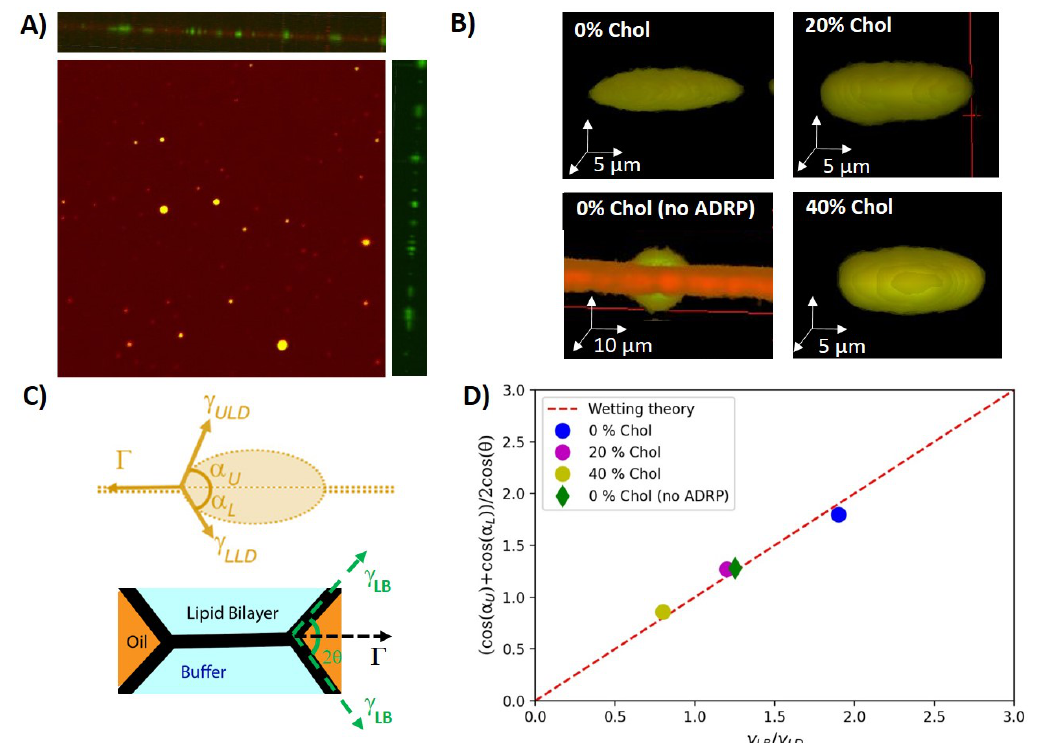
Figure 2. ( A ) Top view of a free-standing bilayer containing LDs. A side view of a 3D scan is provided in the top panel. The right panel provides the corresponding side view with only the protein channel. All the proteins are labeled in green (Alexa 488) and 2% (molar ratio) DOPE is labeled in red (Cy5). ( B ) 3D reconstructions of individual bilayer-embedded LDs for 0%, 20%, and 40% cholesterol, respectively (with 1 µ M ADRP). For comparison, the 3D reconstructions of a bilayer- embedded LD with 0% cholesterol are given, and no ADRP was added. In the latter case, the neutral lipids were stained with BODIPY. ( C ) Scheme of the surface forces acting on a bilayer-embedded LD with an ideal lens shape (upper panel). Scheme of the surface forces acting on the bilayer (lower paner). ( D ) Comparison between wetting theory and the balance of surface forces as extracted from the symmetric 3D LD